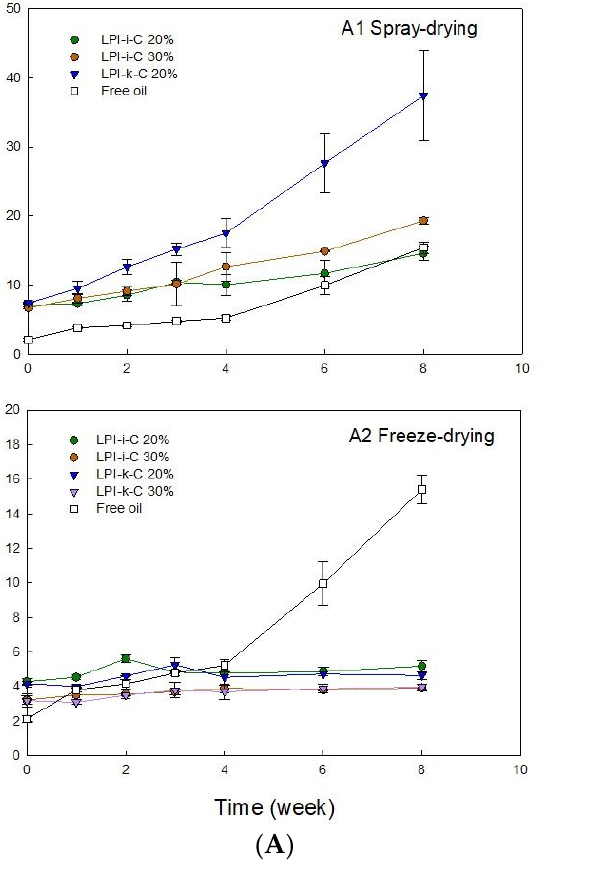
10 of 21 Figure 2. Scanning electron microscopy (SEM) images of the spray-dried LPI- ι -carrageenan (LPI- ι - C) 20% and 30% powders (( A , B ), respectively), and freeze-dried LPI- ι -C 20% and 30% powders (( C , D ), respectively) at 1000× magnification. All the scale bars represent 120 µm. 2.5. Lipid Oxidation of Dried Powders Flaxseed oil is highly susceptible to lipid oxidation due to its high unsaturation level